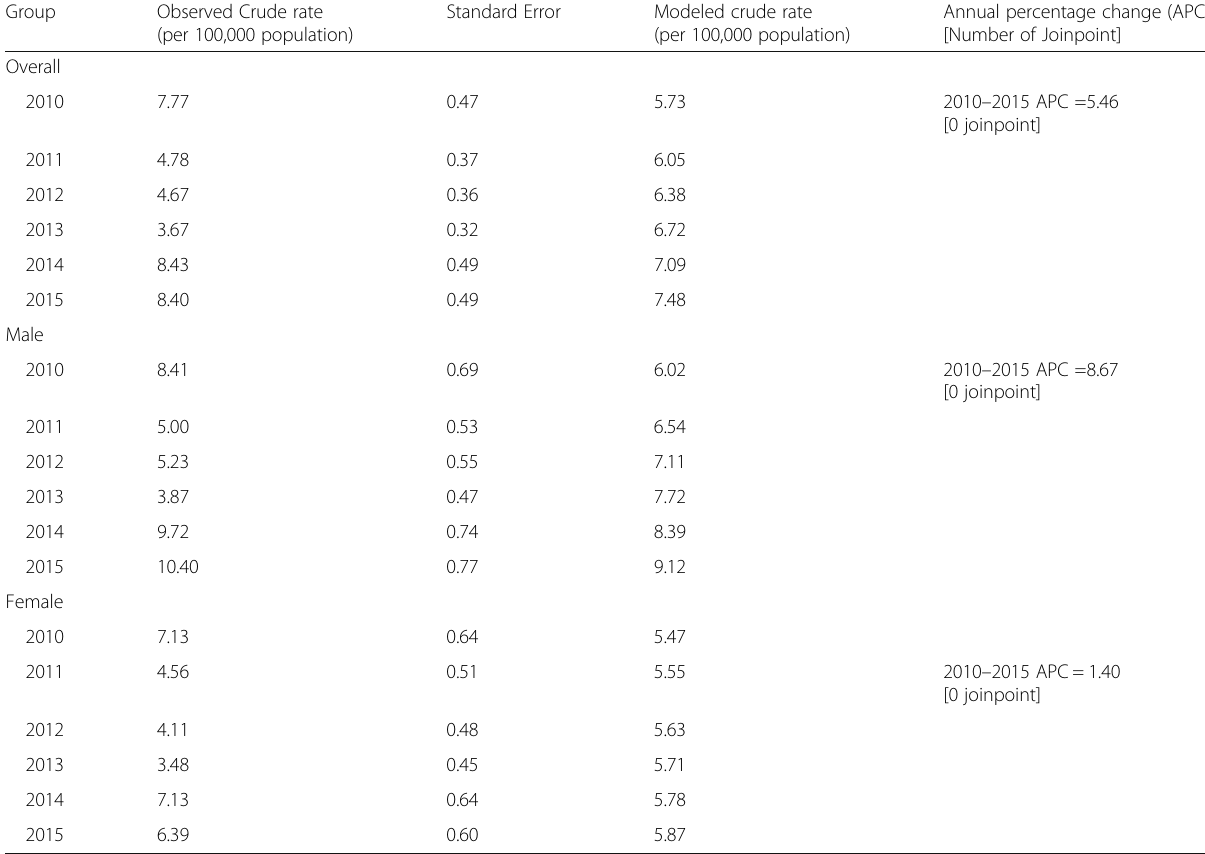
Table 4) Crude and Modeled Suicide rate per 100,000 population calculated using Joint Point Regression model